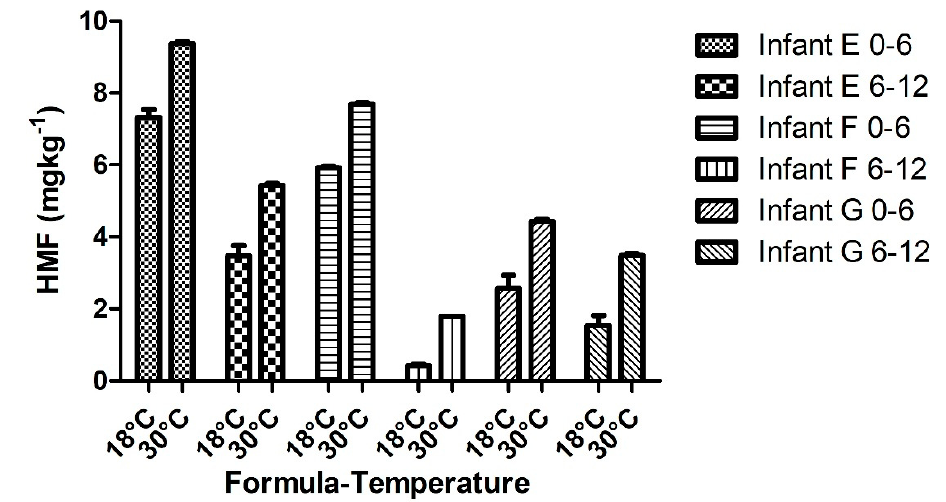
Figure 1. The HMF content in all types of infant formulae.